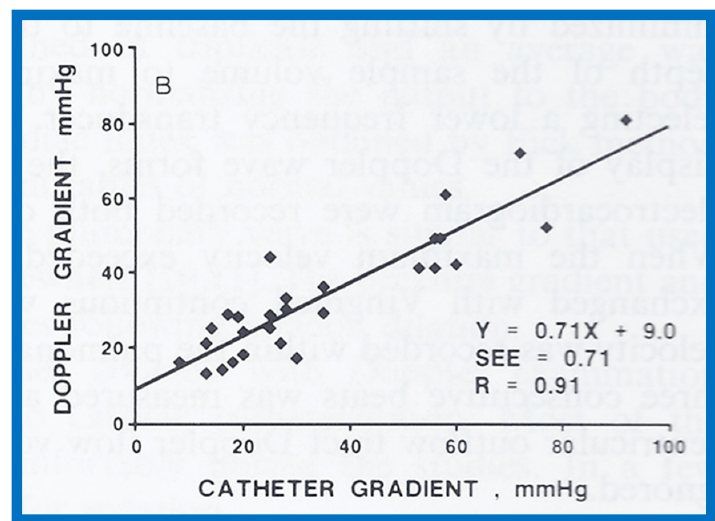
Figure 47. Scattergram demonstrating the relationship of Doppler ‐ derived (by modified Bernoulli equation) peak instantaneous and catheterization ‐ measured peak to peak pulmonary valve systolic